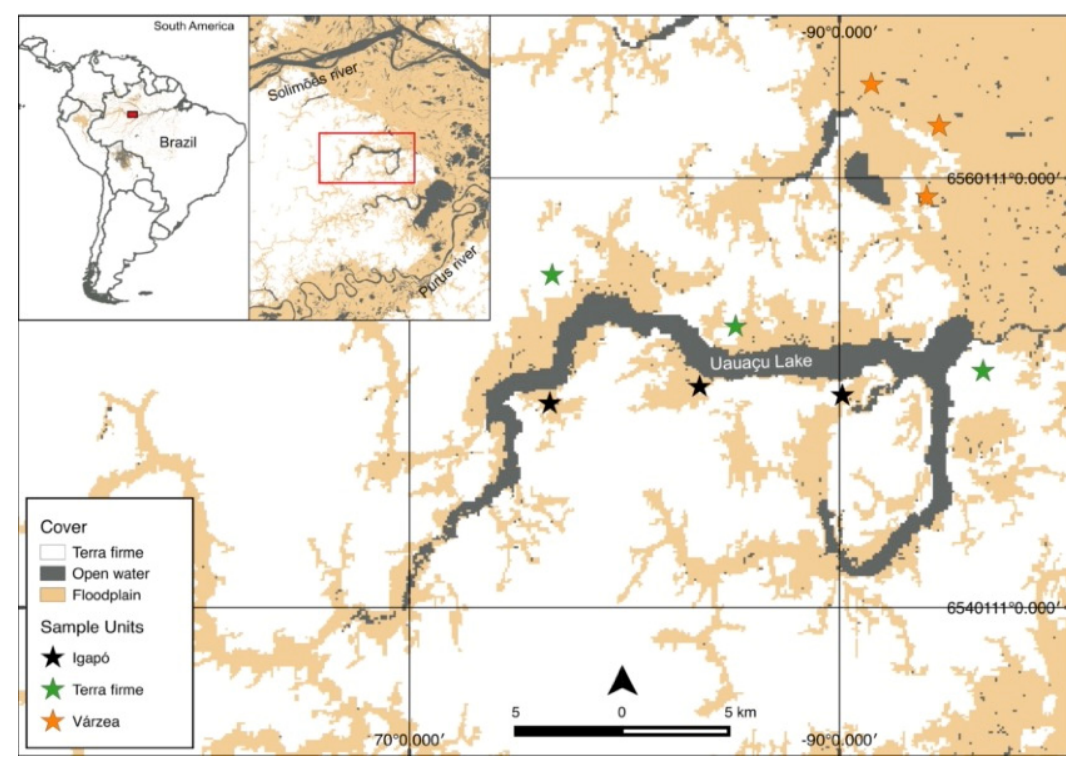
Figure 1. Location of the study and sampling points in the Uauaçu Lake region, state of Amazonas, Brazil. Black stars = igapó , green stars = terra firme, and orange stars = várzea .